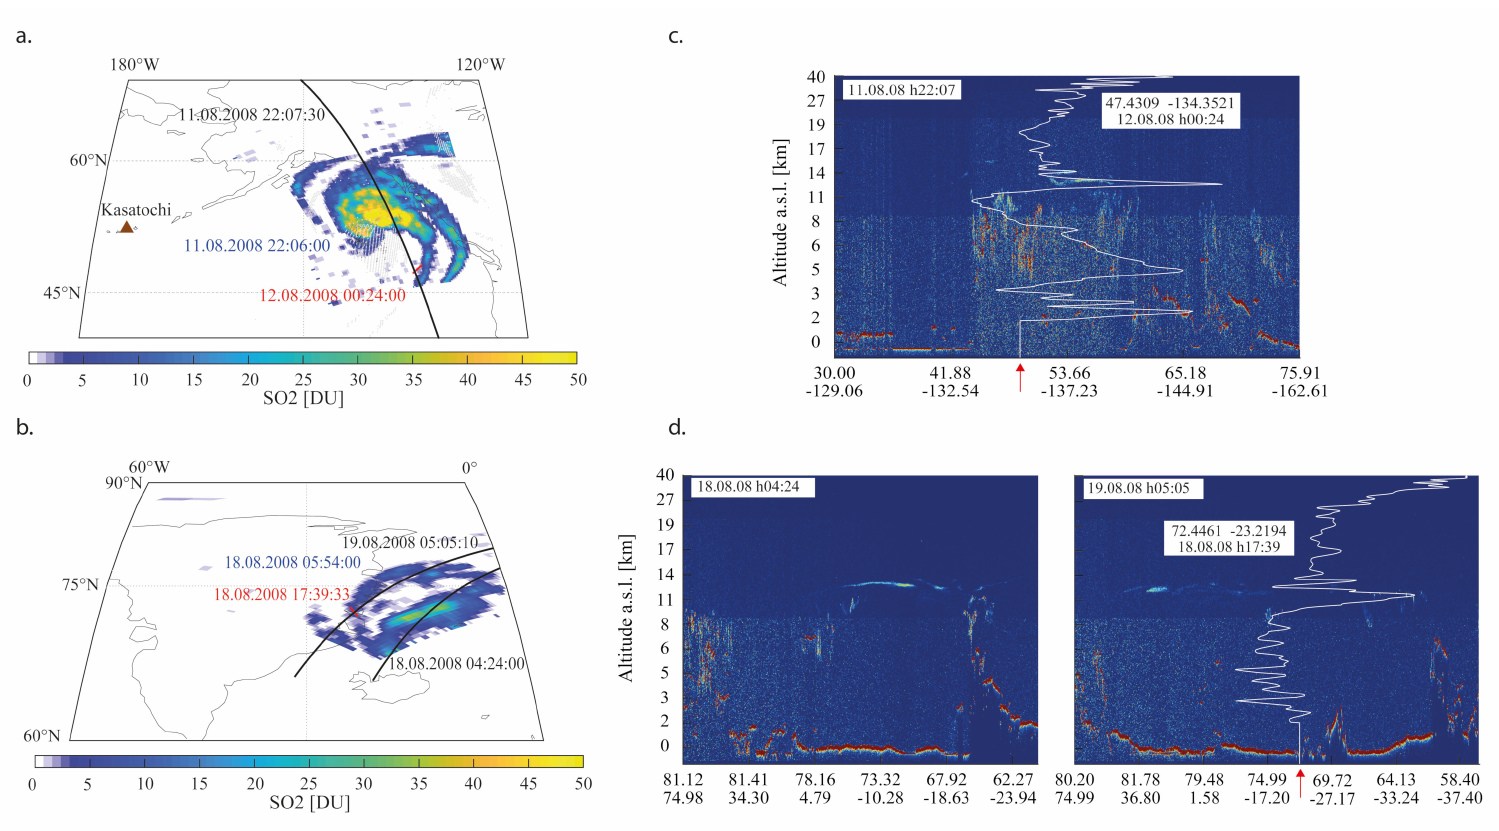
Figure 4. On the left, ( a ) and ( b ) are maps showing the dispersion of the VC ejected by Kasatochi and comprised of both SO 2 in Dobson Units [DU] (color bar) and ash (if present dots in di ff erent greyscale) as detected by atmospheric infrared sounder (AIRS) on 11 and 18 August 2008 (collocation number three and 12, respectively). On the same maps the Cloud-Aerosol Lidar and Infrared Pathfinder Satellite Observation (CALIPSO) track (black line) and the collocated RO profile (red line) are shown. The dates and times represent the passage of the satellites for the present collocation, in blue AIRS, in black CALIOP, and red the RO profile. Brown triangle: Kasatochi volcano. On the right, ( c ) and ( d ) are the related CALIOP backscatter images with the BA anomaly profile collocated and superimposed. On the x-axis of ( c ) and ( d ), CALIOP tracks’ geographical coordinates. A red arrow indicates the zero on the BA anomaly